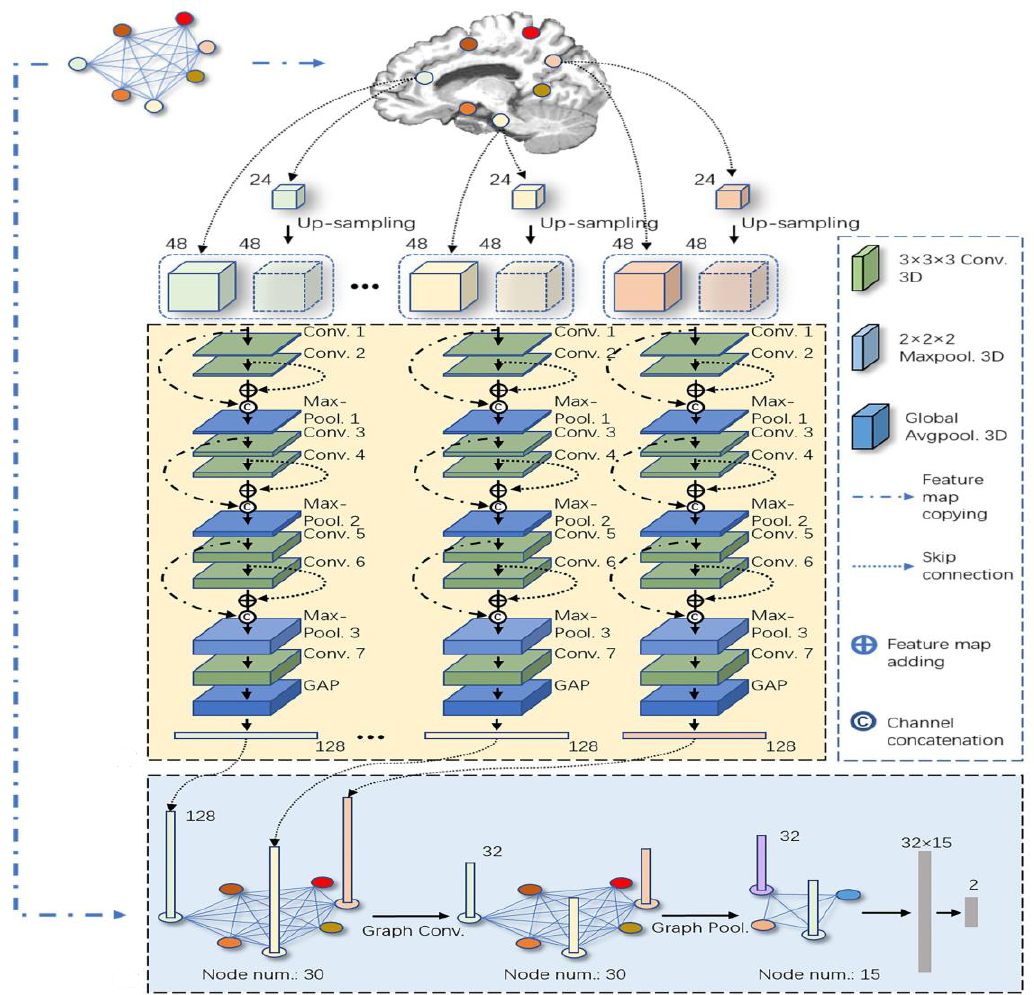
Figure 3. The proposed CCGCN model